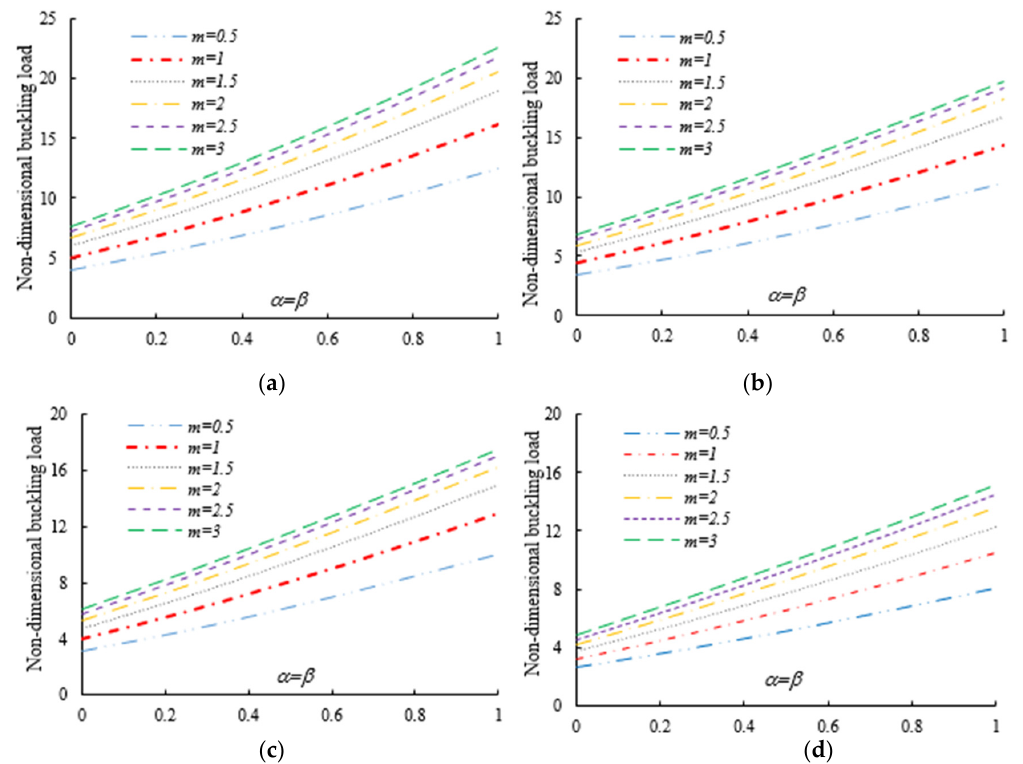
Figure 9. Variation in the flexural–torsional buckling load of I-tapered nanobeams with the tapering ratio and power-law exponent, for different nonlocality parameters (axial load on the centroid): ( a )